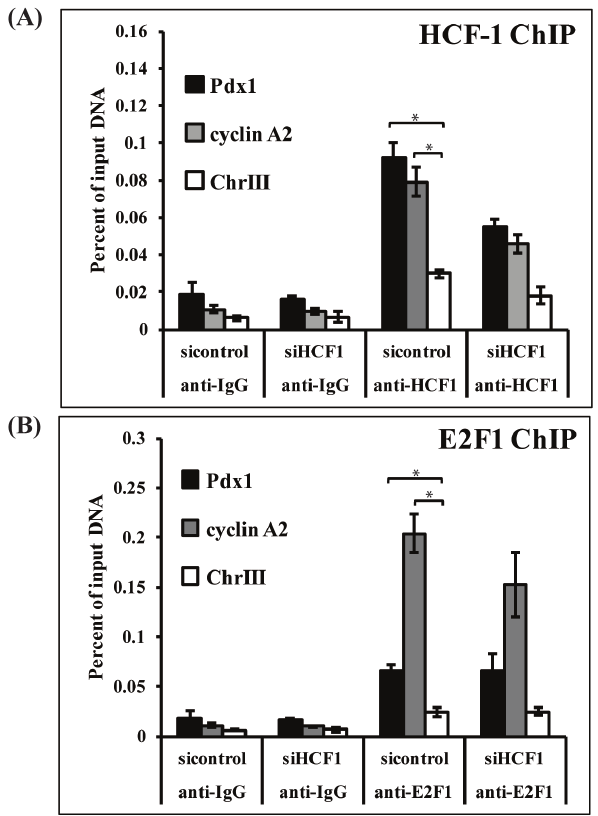
Figure 3. HCF-1 and E2F1 occupy the Pdx1 promoter. INS-1 cells treated with HCF-1 siRNA or control siRNA were subjected to chromatin immunoprecipitation assays using antibodies directed against (A) HCF- 1, (B) E2F1 or isotype-matched rabbit IgG. Immunoprecipitated DNA was quantified using qPCR and calculated as percent of input DNA. Results shown are pooled from three independent experiments and represent the mean + / 2 SEM. HCF-1 and E2F1 enrichment at the Pdx1 and cyclin A2 promoters was significantly greater than at the negative control region (chrIII) (*denotes a p-value , 0.05, Student’s t-test). Knockdown of HCF-1 reduced HCF-1 enrichment at the Pdx1 , cyclin A2 promoters (p-value=0.01) to a significantly greater extent than at the control region promoter (p-value=0.04), whereas E2F1 enrichment was not affected by HCF-1 knockdown. Cyclin A2 is a known E2F1 target and was included as a